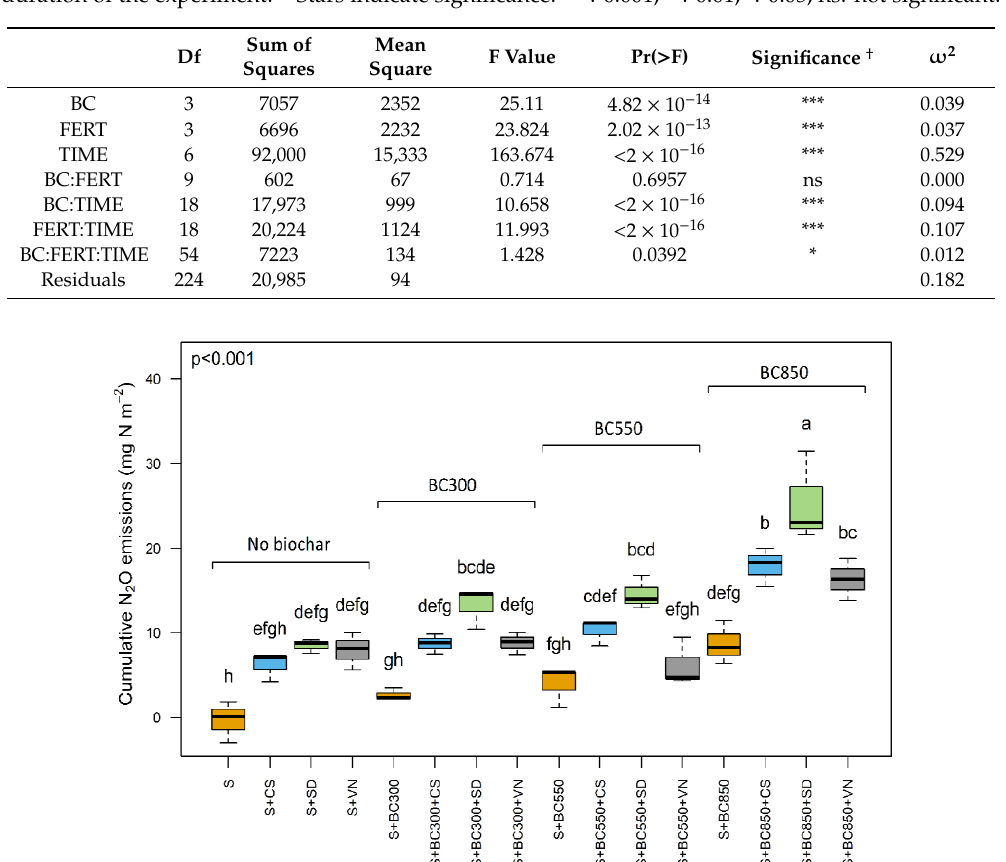
Table 4. Results of the three-way analysis of variance (ANOVA) and effect size (ω 2 ) testing the effects of biochar production temperature (BC), applied fertilizer type (FERT), days since beginning of the application of fertilizer (TIME), and the interactions between these factors on N 2 O fluxes for the full duration of the experiment. † Stars indicate significance: ***: 0.001; **: 0.01; *: 0.05; ns: not significant.